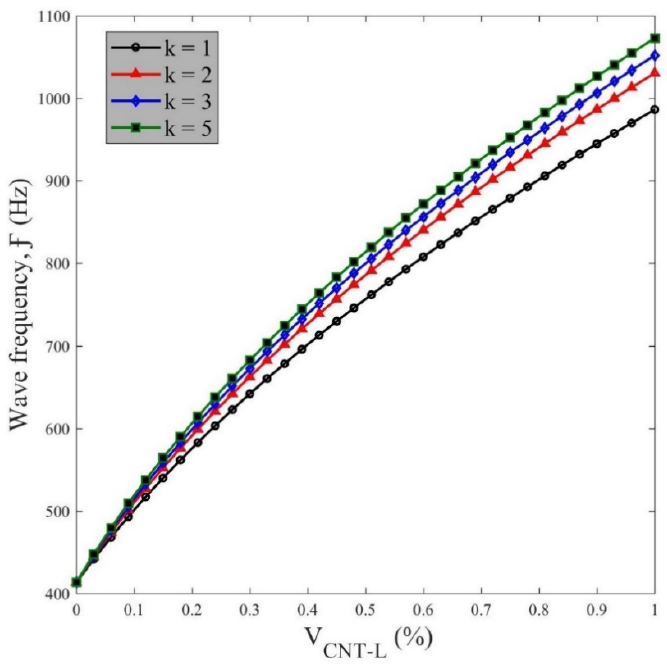
Figure 11. Wave frequency vs. V CNT − L for various k